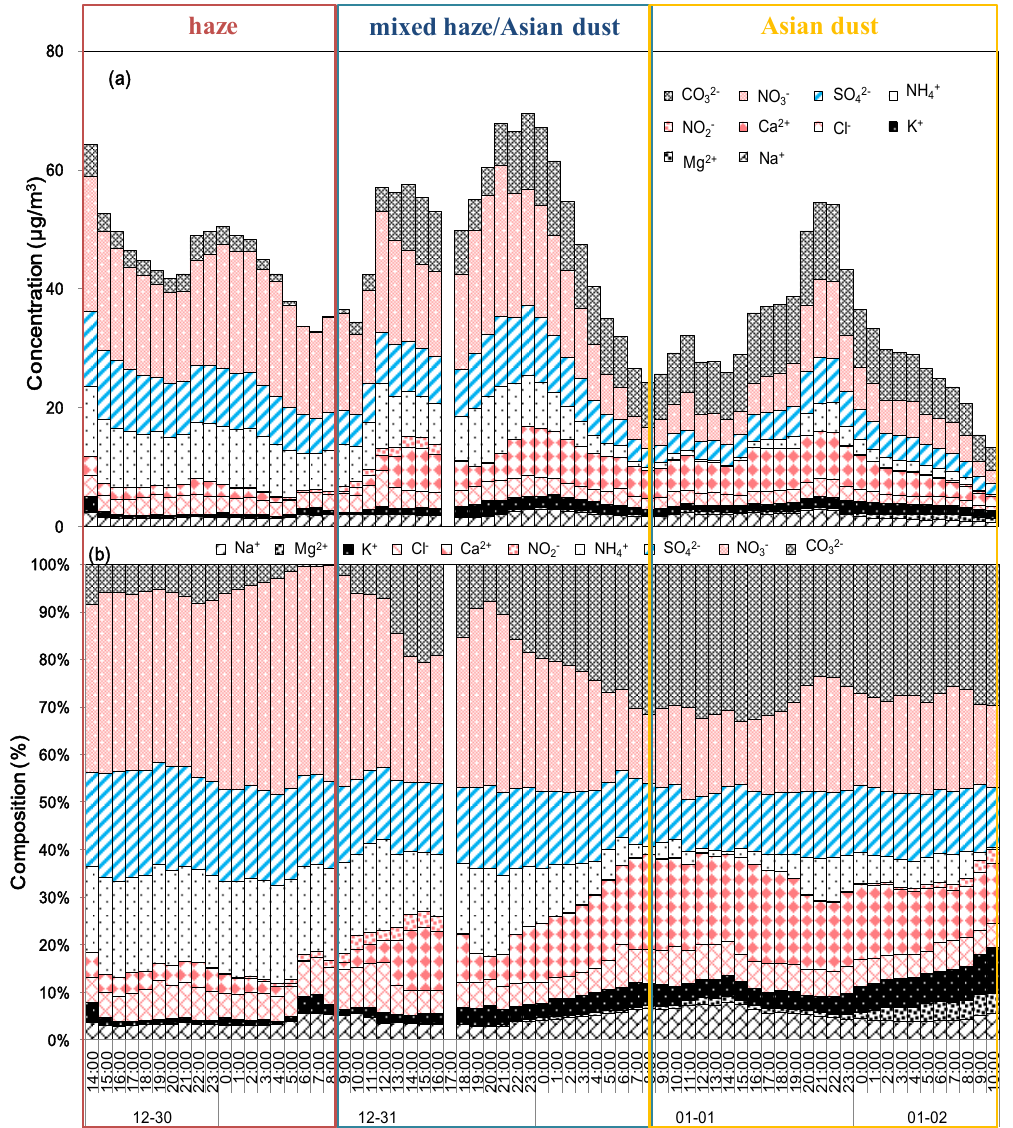
Figure 4. Time series of 1 h averaged ( a ) ionic concentrations and ( b ) their ionic compositions during the study